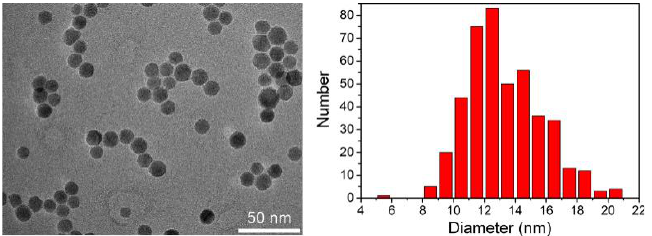
Figure 4. TEM image of iron oxide NPs ( left ) and size distribution measured on 436 NPs ( right ). The average diameter is 13.3 nm, and the standard deviation is 5.9 nm.